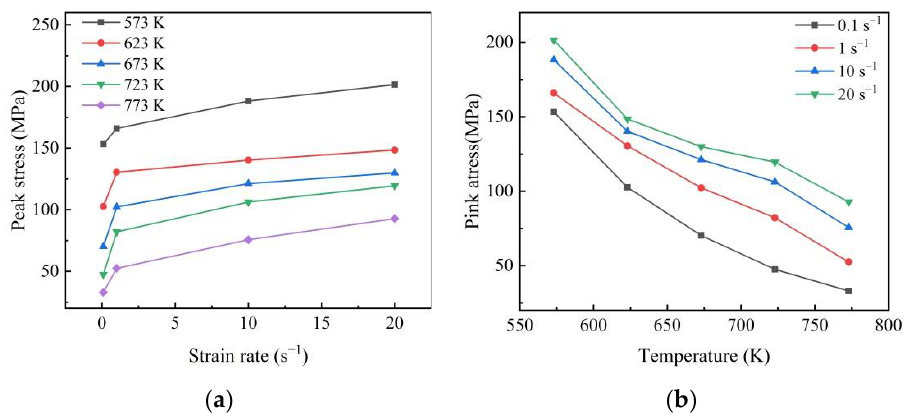
Figure 3. Relationship among flow stress ( a ) deformation strain rate and ( b ) temperature.